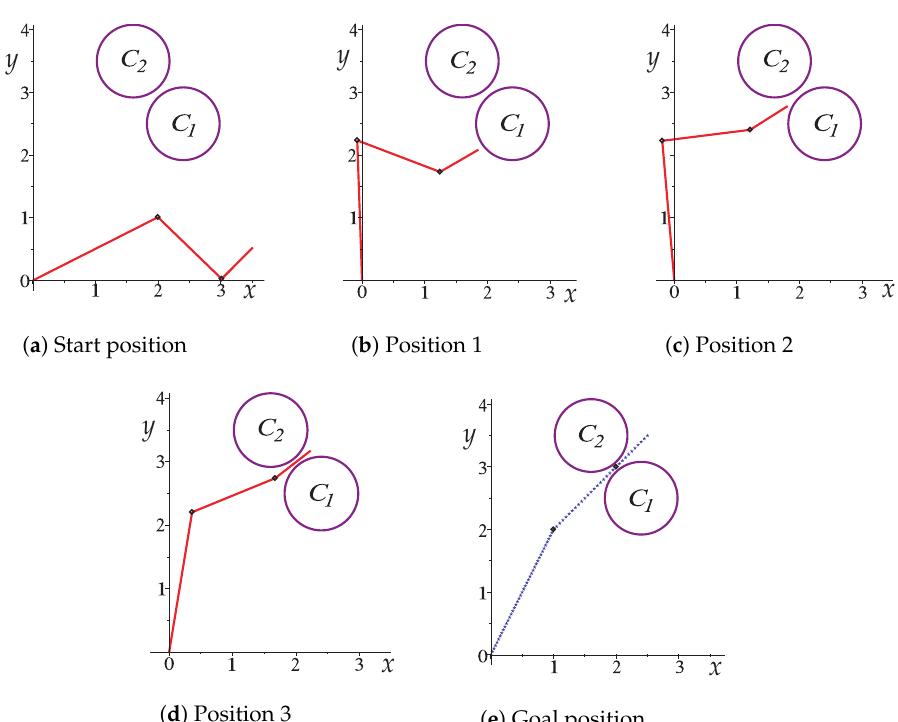
Figure 10. Sequence of images that describe the collision-free path of Case Study 1.